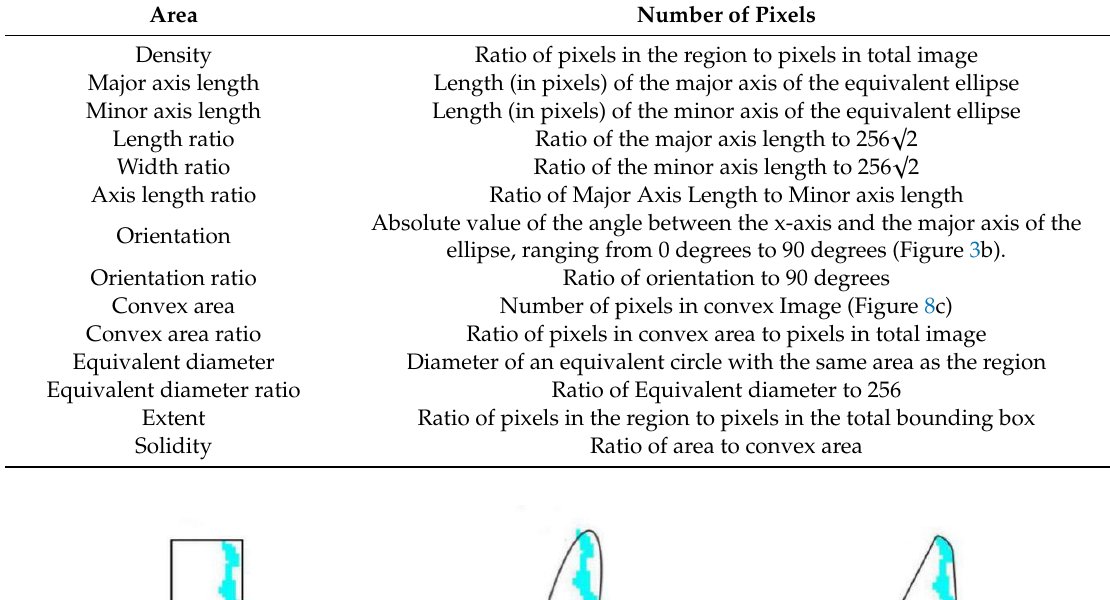
Table 1. Morphological parameters for connected component analysis.